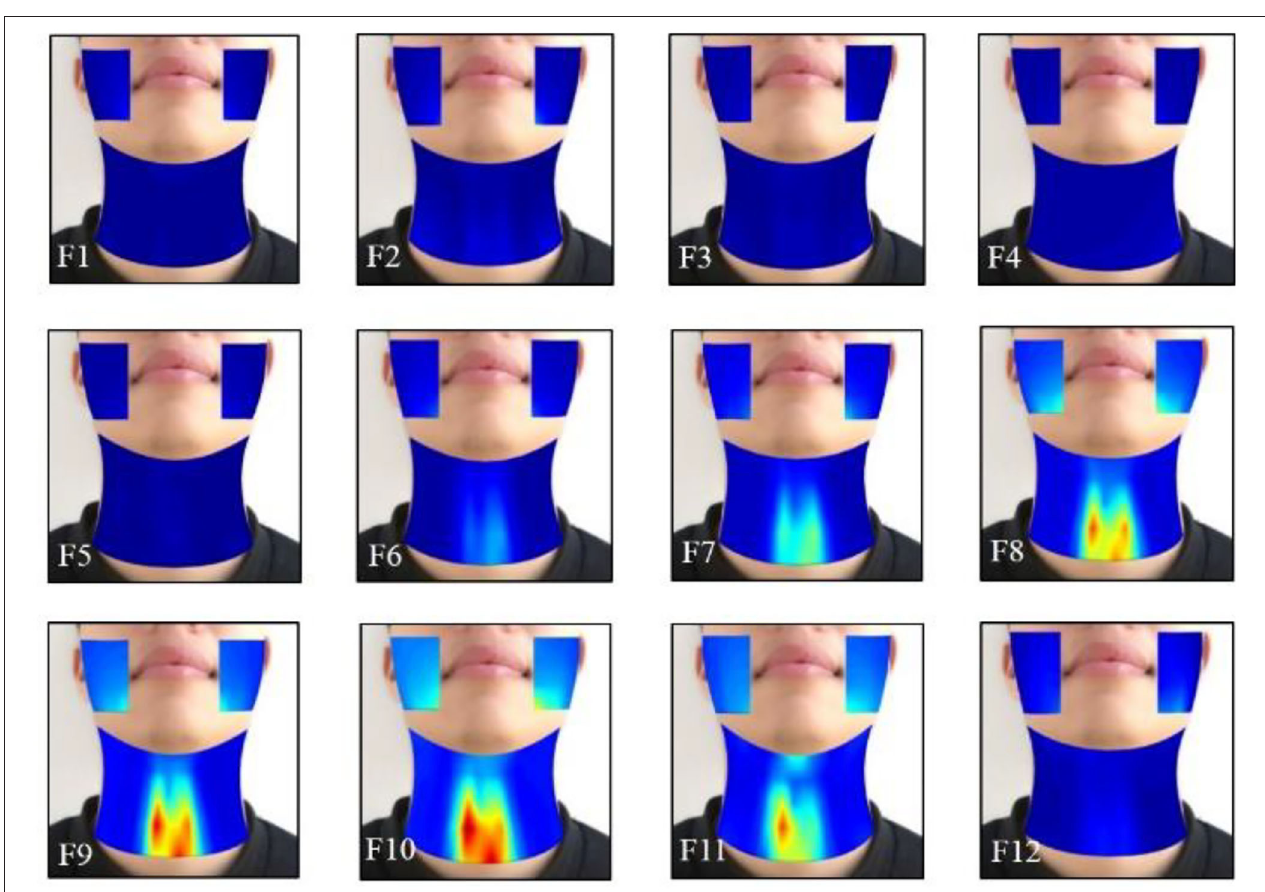
FIGURE 8 | The averaged HD sEMG energy maps of the facial and neck muscles during the phonating vowel [e:] on a rising pitch scale.